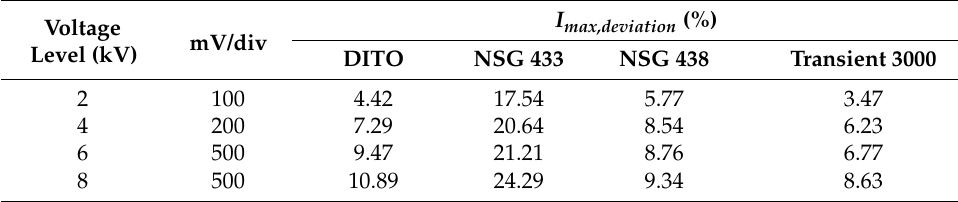
Table 7. I max deviation for different test levels and ESD generators [19].